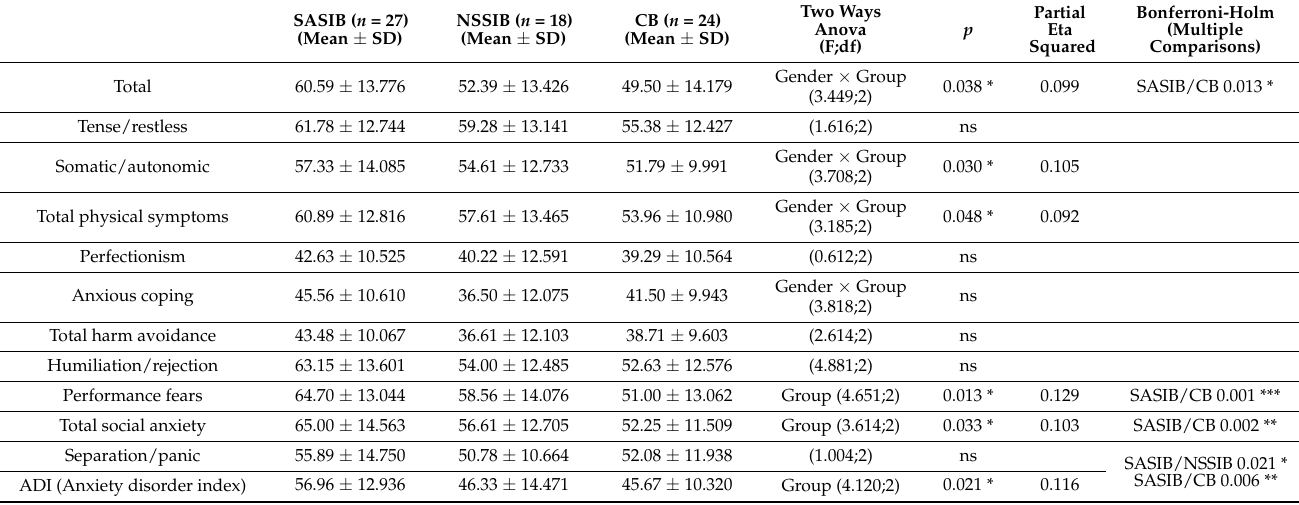
Table 4. Two-way ANOVA corrected by gender: Comparison between the three groups according to the Multidimensional Anxiety Scale for Children (MASC).